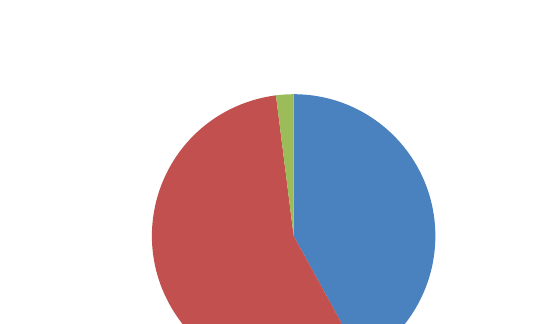
Figure 1: Regression analysis results [3].